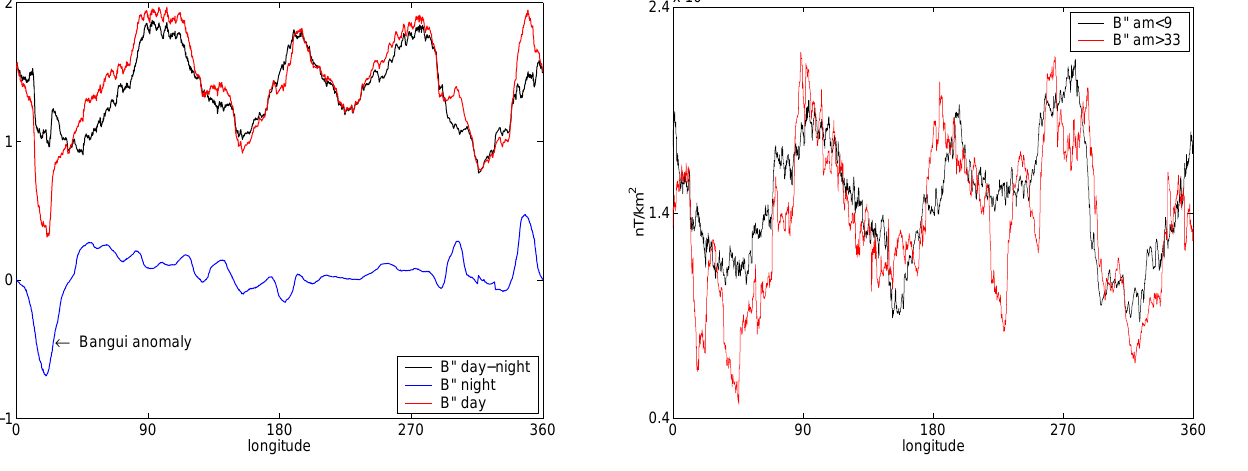
Fig. 8. Profile along the dip equator of the equatorial electrojet field, longitudinal component (in nT/km 2 ), using data from the whole interval 2001-2004 (in black); results obtained without removing the crustal field, using data from 6 hours of day only (in red) and 6 hours of night only (in blue). The anomaly is projected onto the normal to the dip equator and then averaged over a 500 km wide and 1300 km long window sliding along the equator.